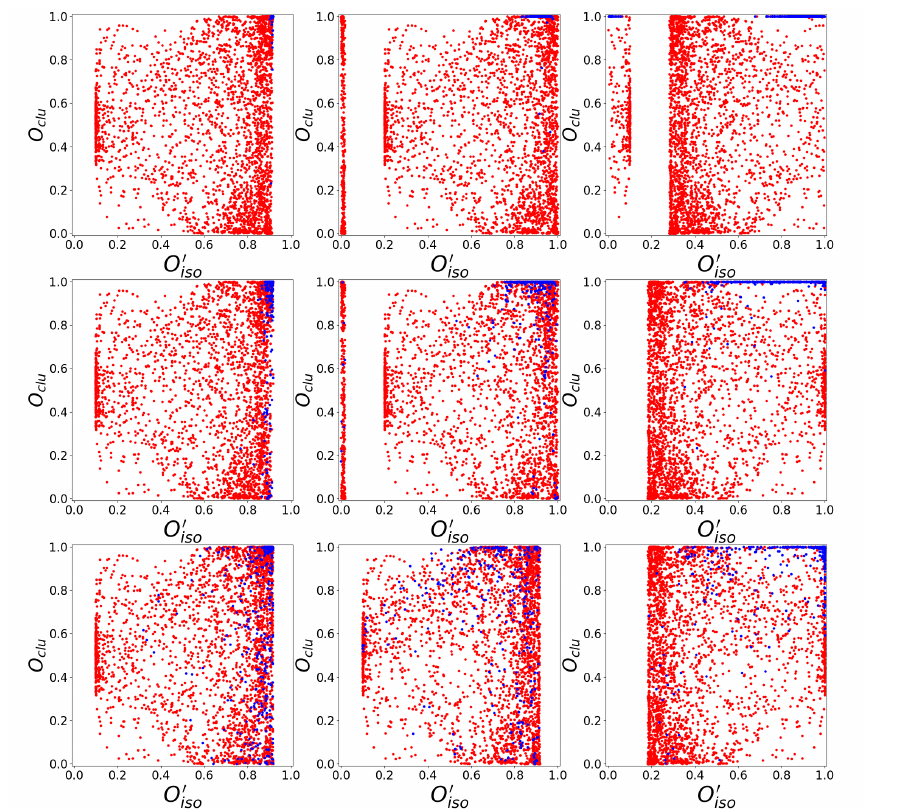
− O clu plane for the 2D Gaussian testing iso